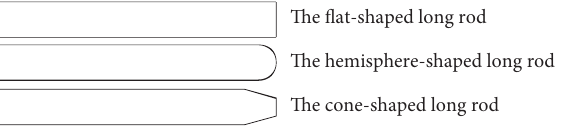
Figure 7: Three nose shapes for the long rod.